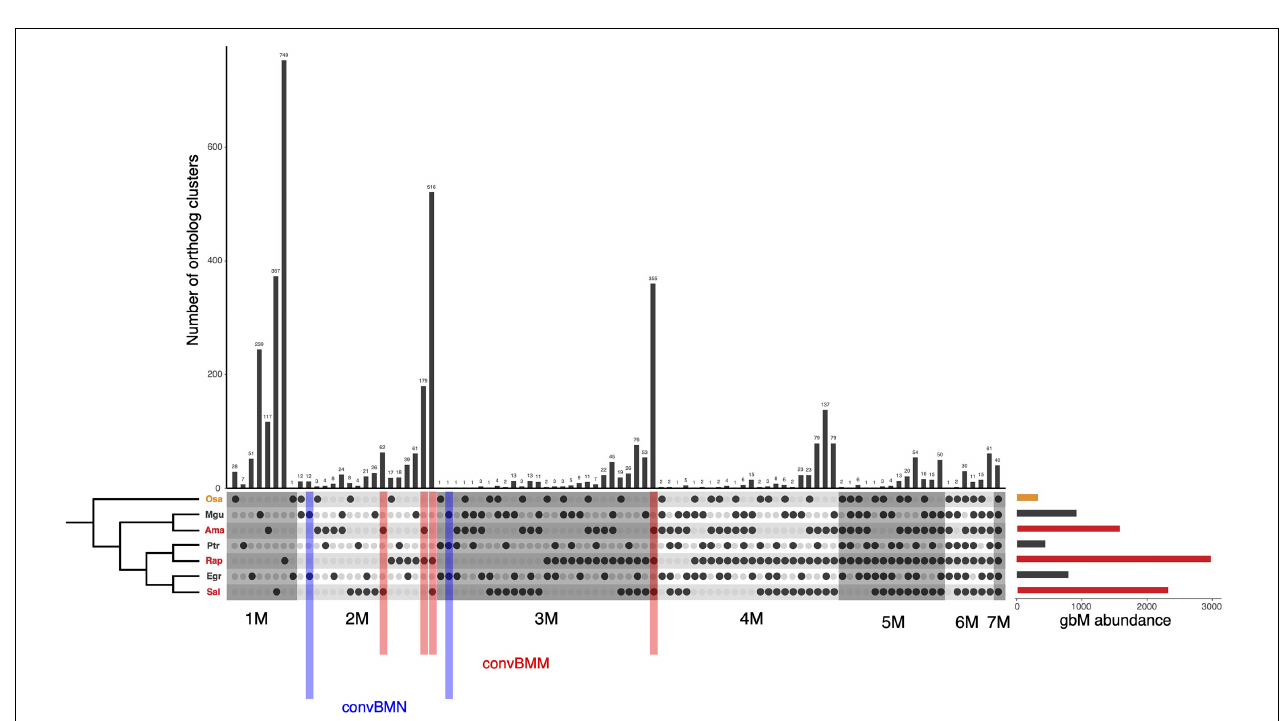
FIGURE 2 | gbM gain and loss across orthologs of mangroves and non-mangrove species. The estimated numbers of gain (red) and loss (blue) of gbM at each internal node are given in parentheses. The estimated numbers of gbM gain and loss in each branch are indicated with plus in red or with minus in blue, respectively. BM, CG body-methylated genes, UM, unmethylated genes.